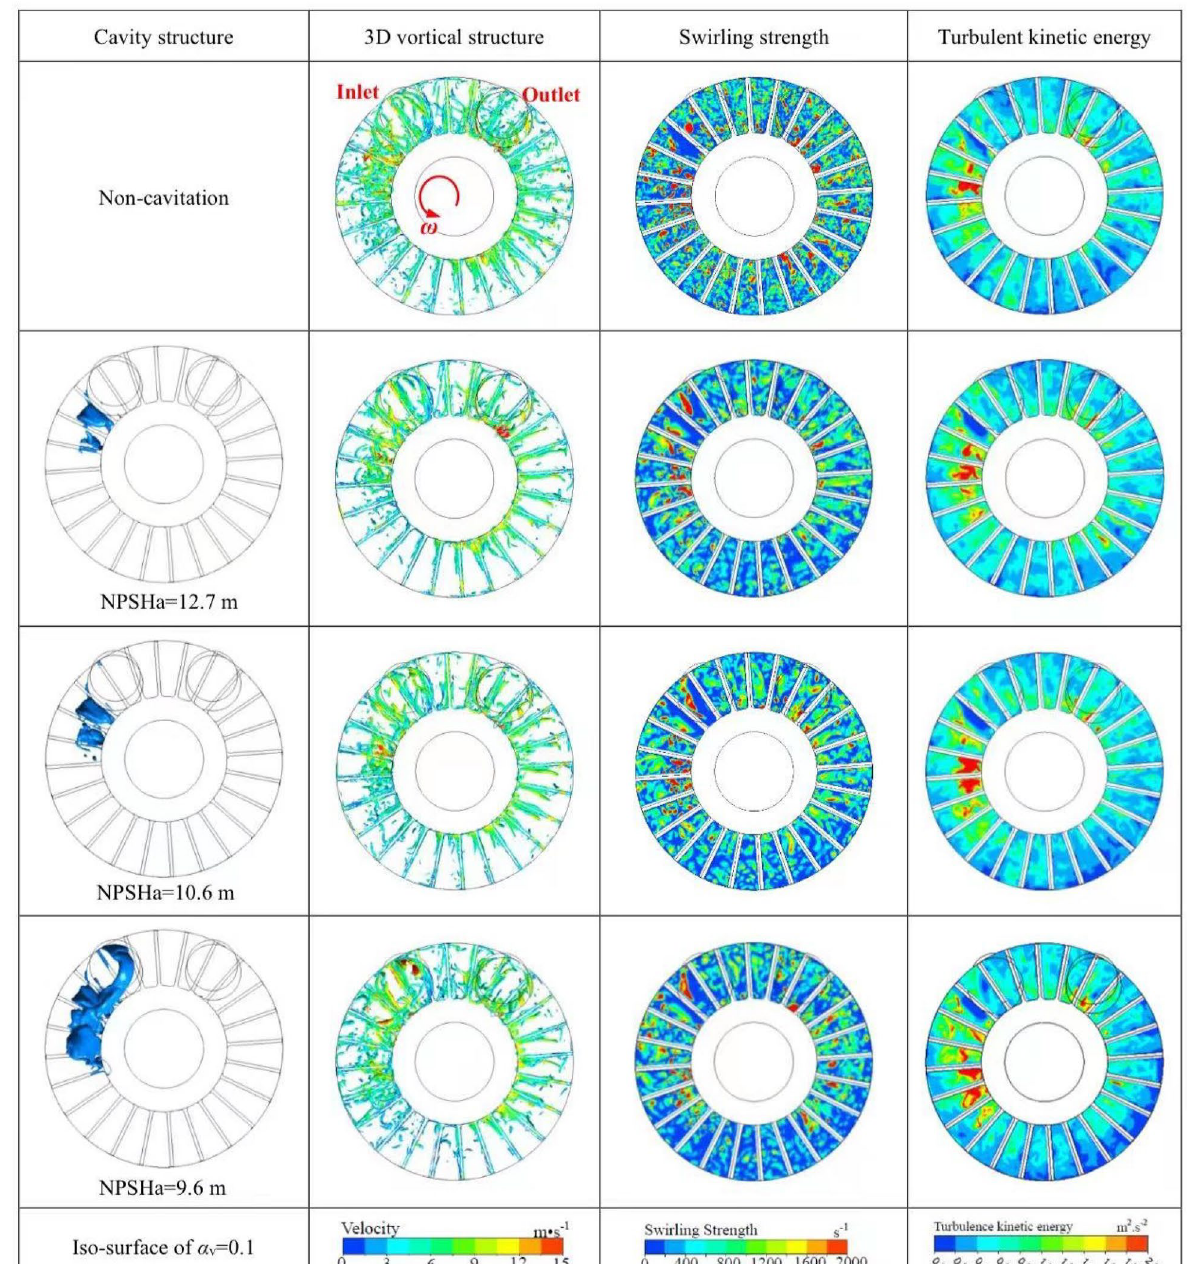
Figure 8 Distributions of cavity, vortical structures and turbulent kinetic energy at a typical instant ( t